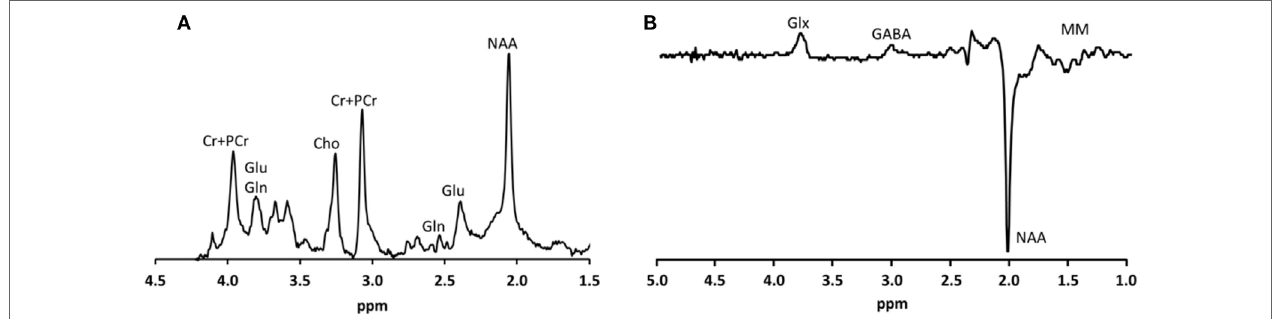
FigUre 1 | Typical metabolite spectra (a) as recorded using the sLASER sequence and (B) as recorded using the MEGA-sLASER